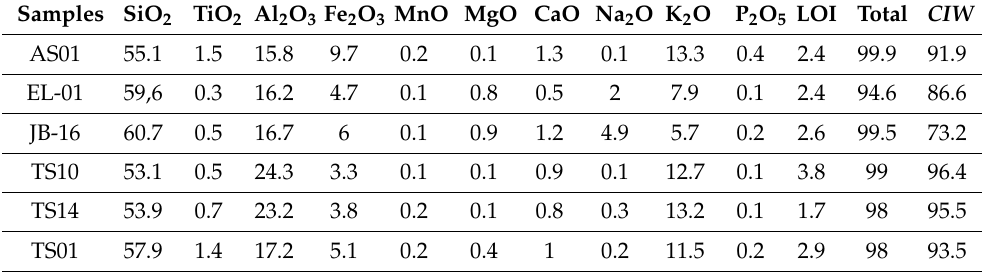
Table 2. X-ray fluorescence analysis for selected samples and chemical index weathering val- ues ( CIW